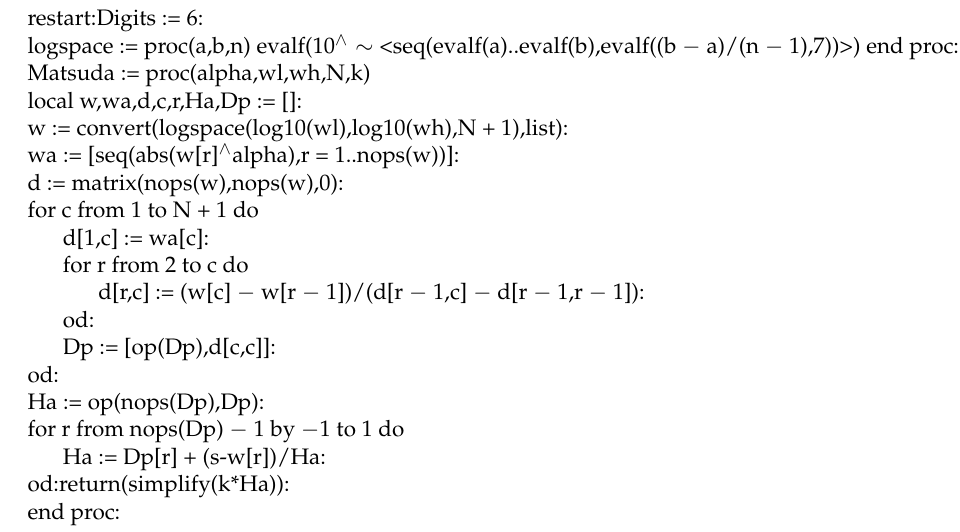
Table 11. Matsuda’s method coded in Maple 18